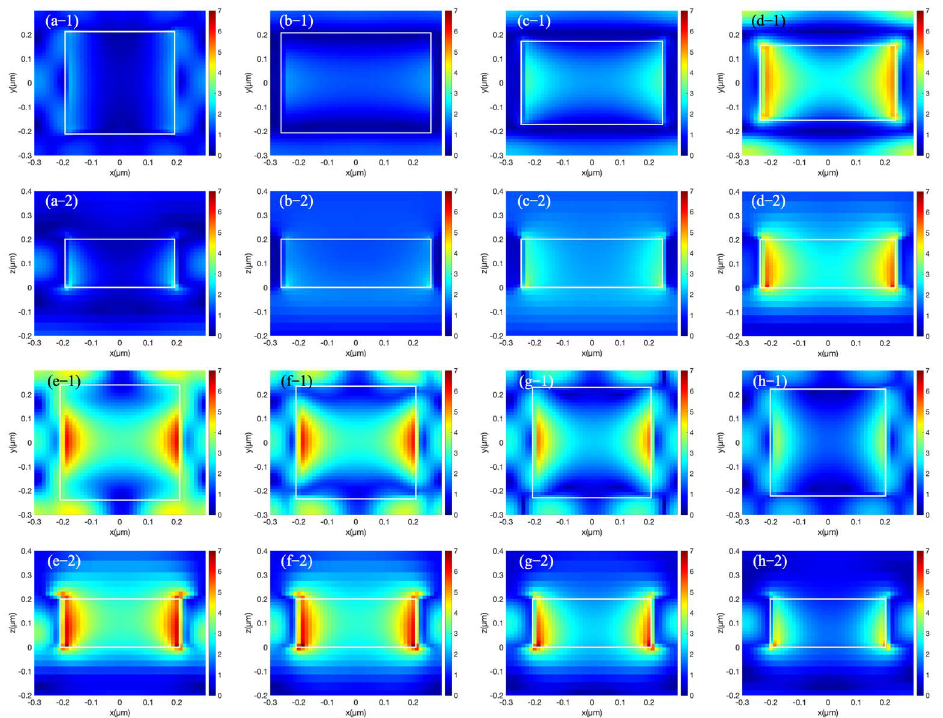
Figure 5. Electric field distributions of the eight selected unit-cells with nanoholes: ( a − 1 − h − 1 ) Normalized electric field distribution on the x − y plane with z = 100 nm; ( a − 2 − h − 2 ) Normalized electric field distribution on the x − z plane with y = 0 nm.